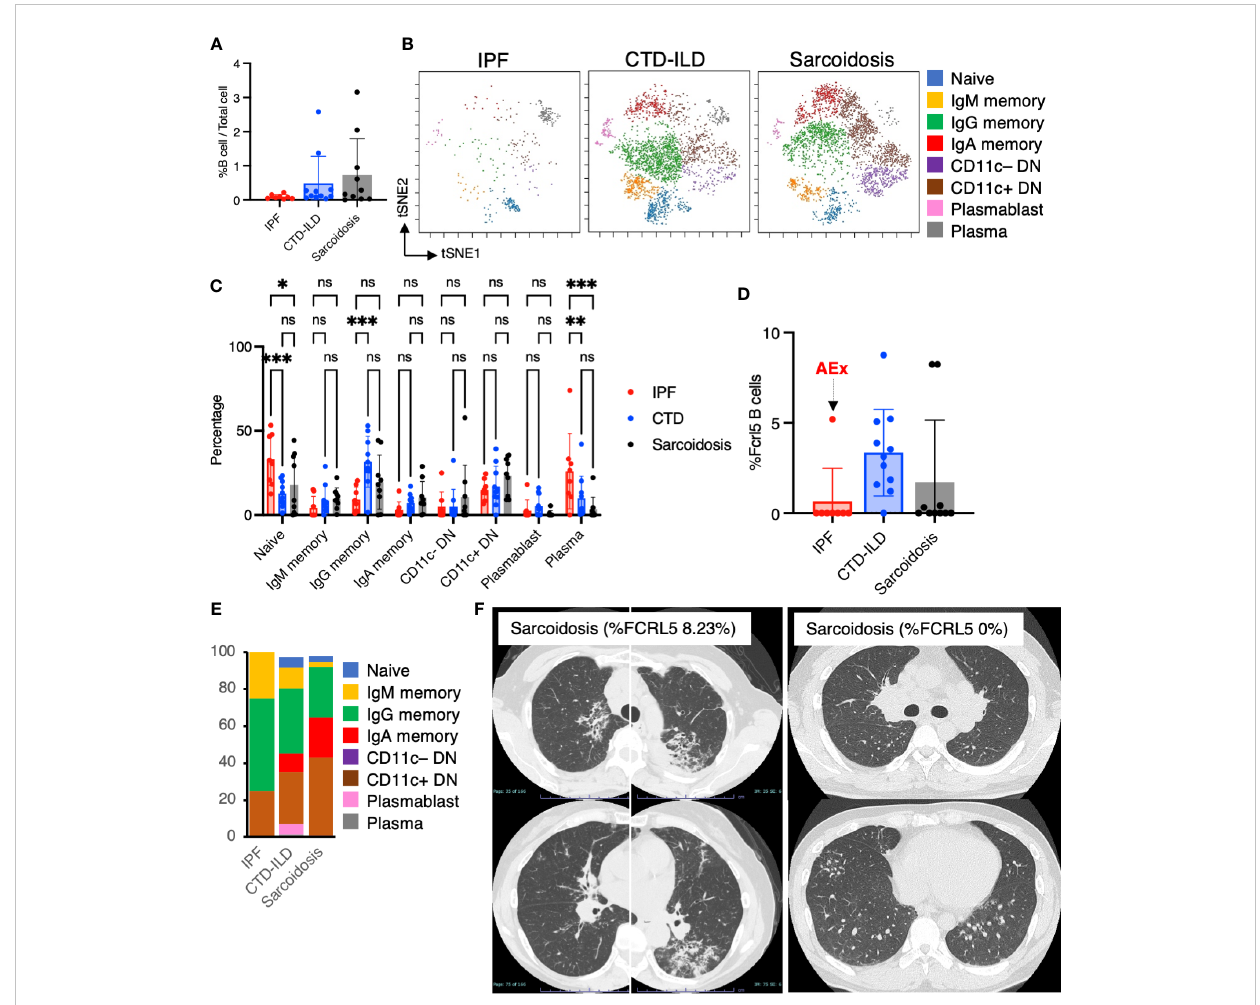
FIGURE 4 Characterization of B cell subsets in BALF from patients with IPF, CTD-ILD, and sarcoidosis. (A) Percentage of B cells and plasma cells in CD45 + BALF cells. (B) t-stochastic neighborhood embedding (t-SNE) plots of concatenated samples visualizing the distribution of B cell sub-populations in CD64 – CD3 – and CD19 + or CD138 + gated B cells in BALF from patients with IPF, CTD-ILD, sarcoidosis. Naive B cells are de fi ned by CD19 + IgD + , IgM memory B cells: CD19 + IgM + CD27 + , IgG memory B cells: CD19 + IgG + CD27 + , IgA memory B cells: CD19 + IgA + CD27 + , CD11c – double negative (DN) B cells: CD19 + CD11c – IgD – CD27 – , CD11c + DN B cells: CD19 + CD11c + IgD – CD27 – , plasmablasts: CD19 + CD27 + CD38 + CD138 – , plasma cells: CD19 – CD138 + and IgG + or IgA + . (C) Percentage of B cell sub-populations in IPF, CTD-ILD, and sarcoidosis. Graphical plots represent individual samples. (D) Percentage of FCRL5 expressing B cells in total B cells. ns: not signi fi cant, * p < 0.05, ** p < 0.01, *** p < 0.001. (E) The proportion of each B cell subsets in FCRL5 expressing B cells. (F) Representative chest CT images of patients with sarcoidosis exhibiting a high percentage of FCRL5 B cells and a low percentage of FCRL5 B cells in